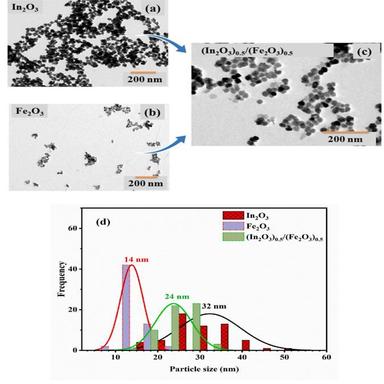
TEM micrographs of (a) In2O3, (b) Fe2O3, (c) (In2O3)0.5/(Fe2O3)0.5 composites and (d) their particle size distribution histogram.